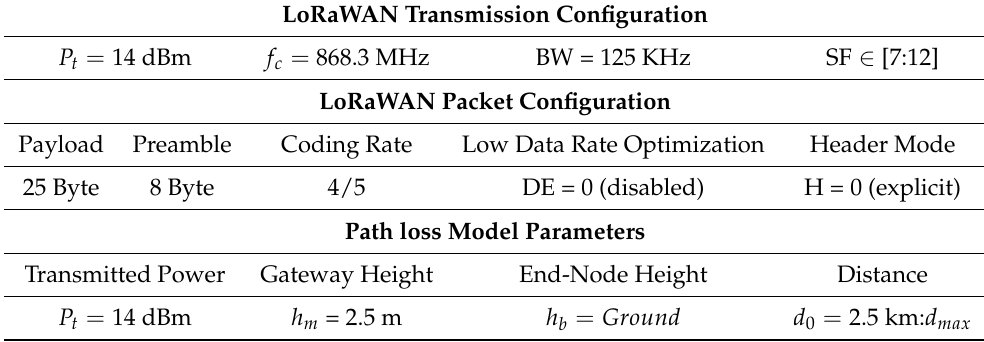
Table 3. Experiment and simulation